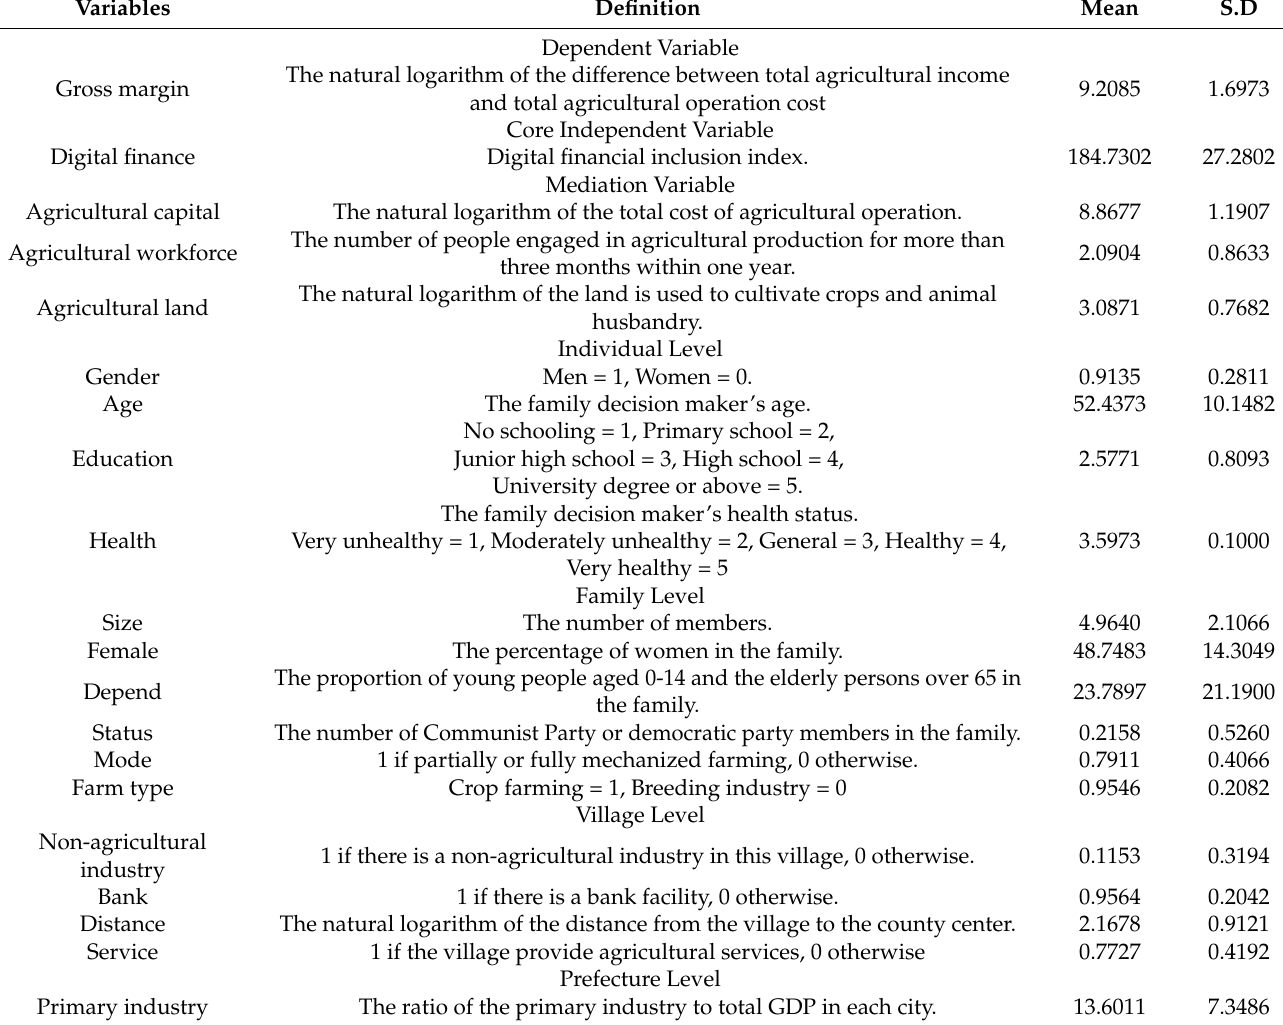
Table 1. The definitions and descriptive statistics of each